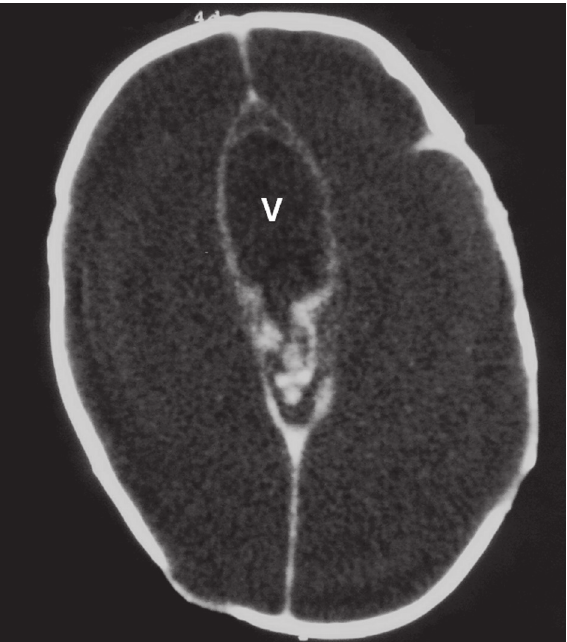
Figure 3. CT image of 2 days old newborns brain. Dilated third ventricle (V) with absent thalami and basal ganglia and cerebral cortex.